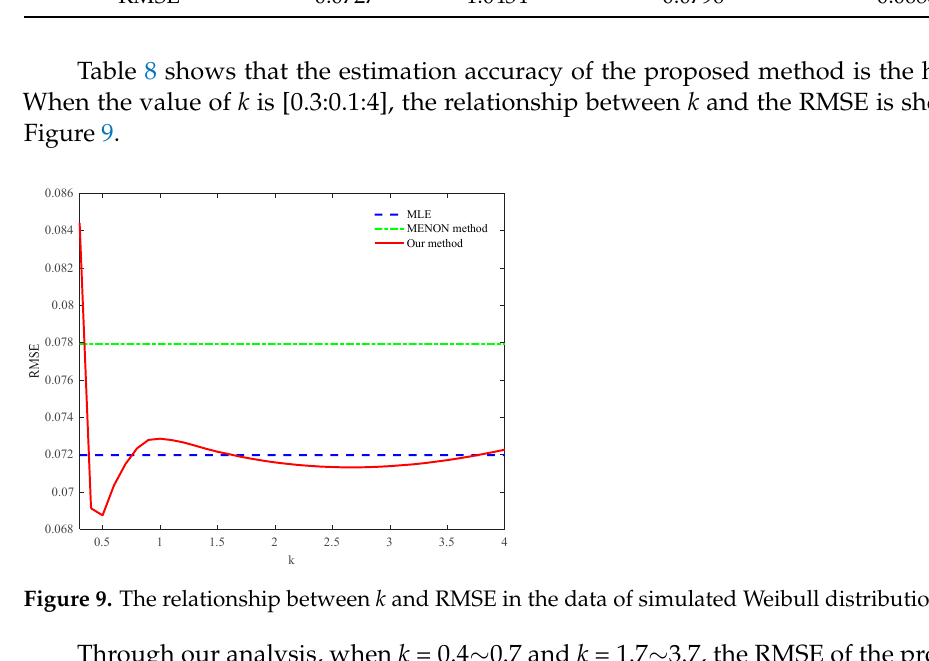
Table 8. The statistics of estimation accuracy in simulated Weibull distribution ( k = 0.5). Estimation Method MLE ME MENON Method Our Method RMSE